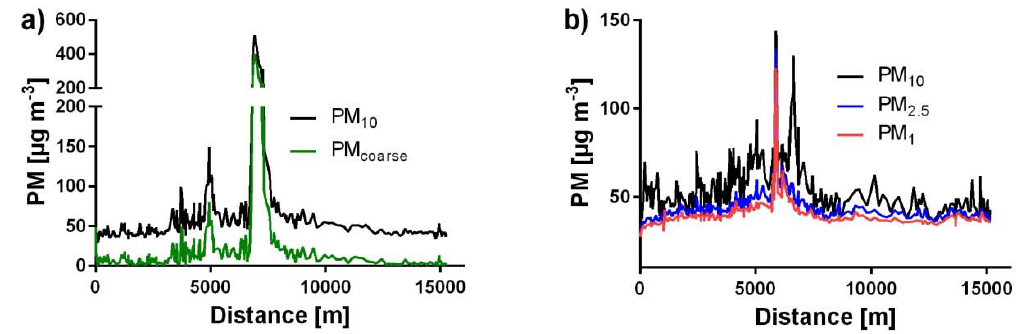
Figure 4. Representative short-term concentration peaks measured with an opened window on 10-20-15. ( a ) At noon, ( b ) in the afternoon.